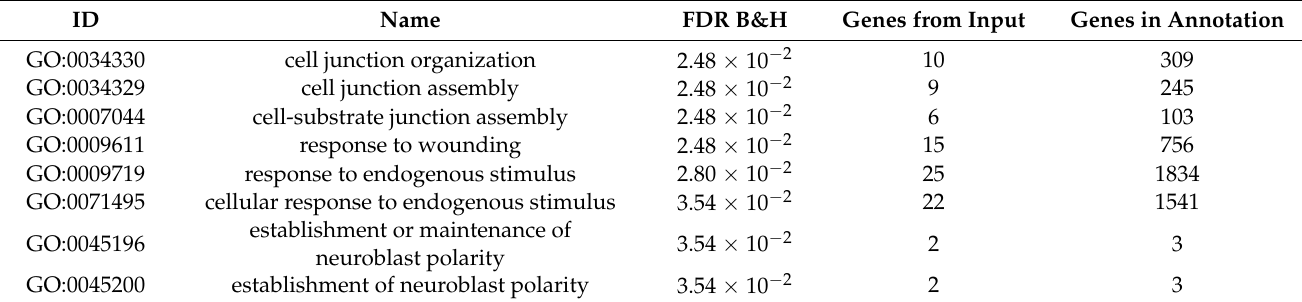
Table 3. Biological processes regulated by Activin-A in FOP cells.